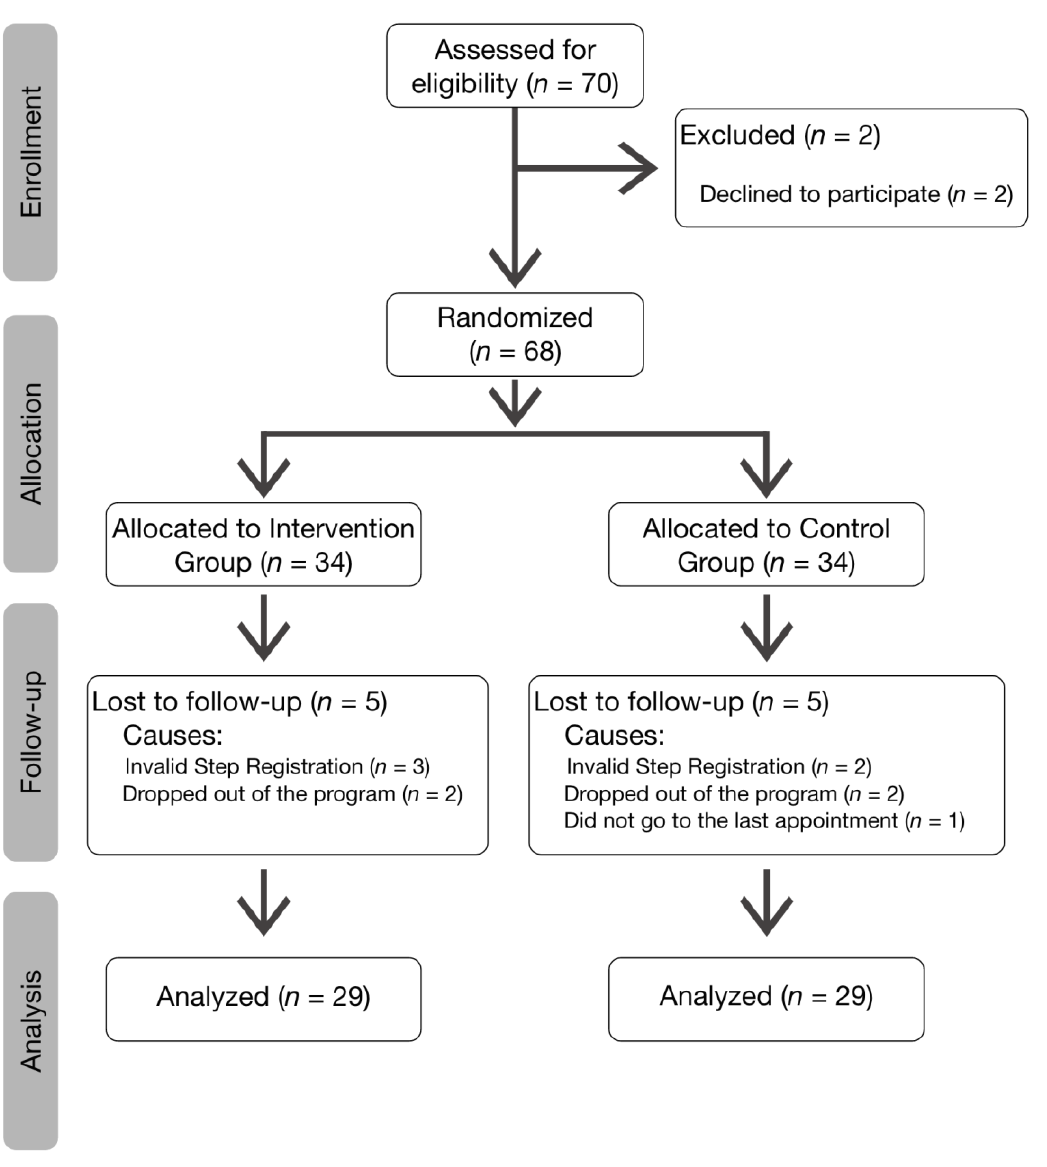
Figure 3. CONSORT flow diagram.